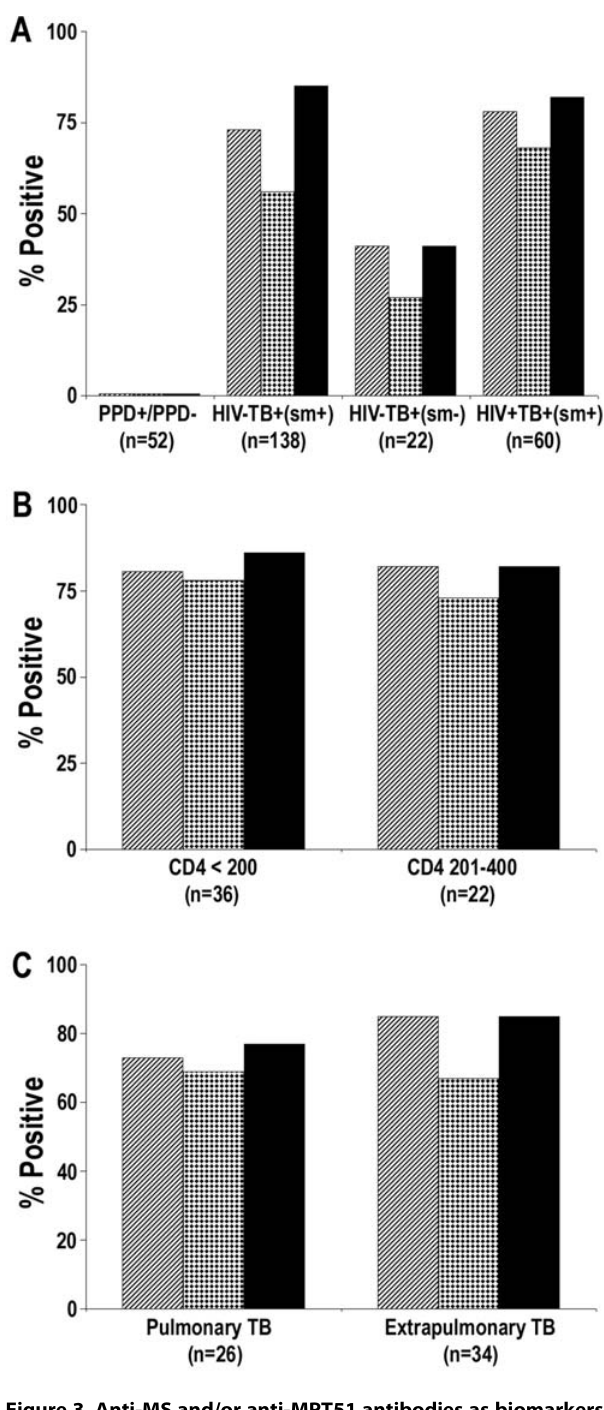
Figure 3. Anti-MS and/or anti-MPT51 antibodies as biomarkers for TB in different categories of patients: Presence of the two biomarkers in smear-positive HIV 2 TB + , smear-negative HIV 2 TB + and smear-positive HIV + TB + patients (A). Presence of the biomarkers in HIV + TB + patients with CD4 + T cell numbers , 200/ul or between 201– 400 (B). Presence of the biomarkers in HIV + TB + patients with pulmonary TB or extrapulmonary TB (C). In all figures, bars with diagonal lines represent anti-MS antibodies, bars with dots represent anti-MPT51 antibodies and additive reactivity with both biomarkers is represented by solid black bars. Numbers in parenthesis indicate number of subjects in each group.